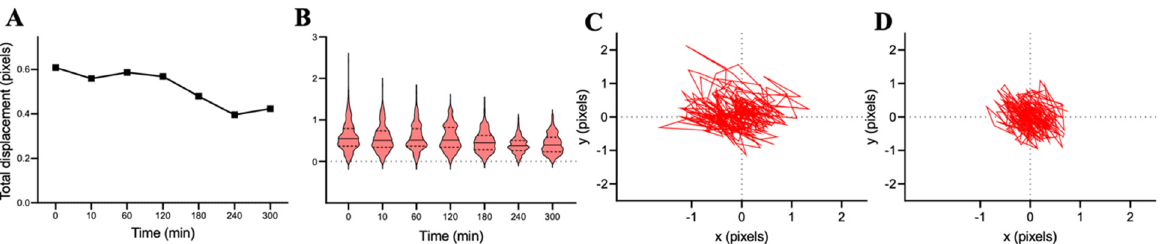
Figure 10. E ff ect of antifungal caspofungin (1 µg/mL) on the cellular nanomotion of cell 8 from Fig- ure 9C ( C. albicans CAF2 − 1). ( A ) Total displacement (pixels) as a function of time for cell 8 (see also a movie of cell 8 that was recorded before treatment (Video S3) and at 10 min (Video S4). ( B ) Distri- bution of the displacement/frame as a function of time for cell 8. ( C ) X − y displacement of cell 8 before